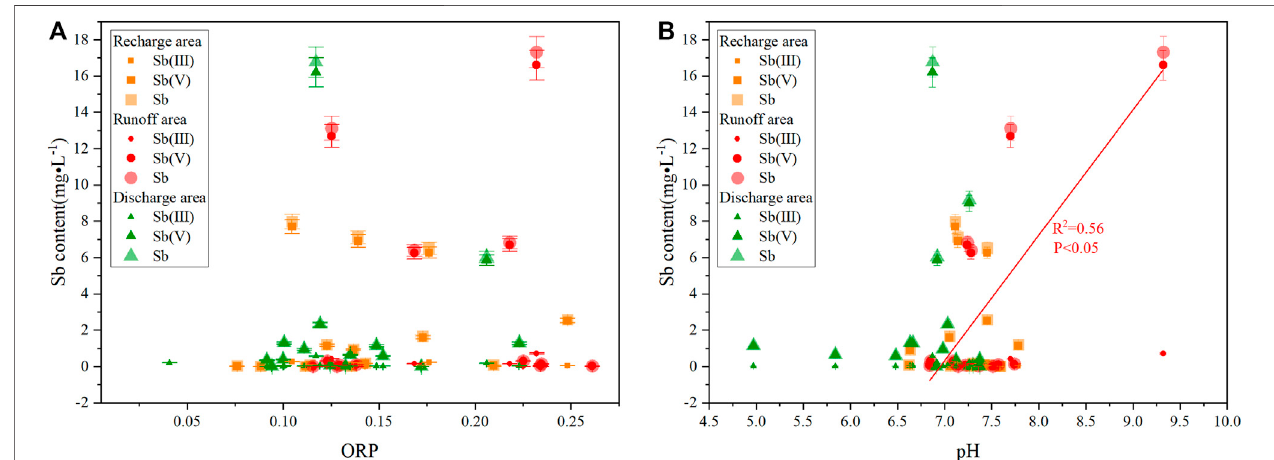
FIGURE 8 | (A) ORP versus Sb; (B) pH versus